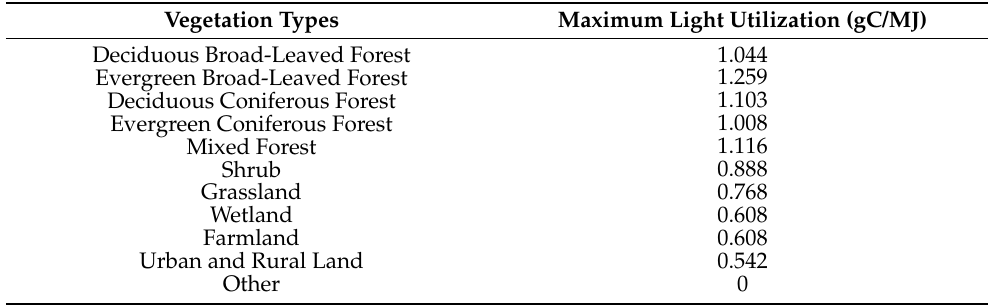
Table 1. Maximum light utilization rate of the vegetation types in the six provinces along the southeast coast of